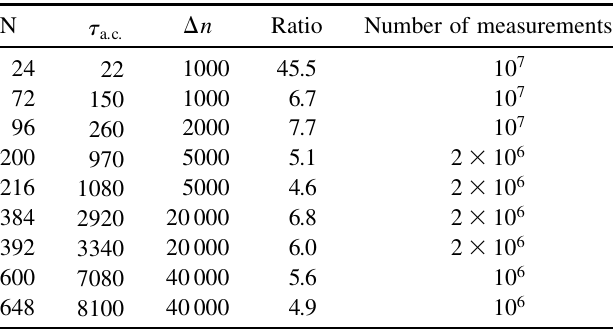
TABLE I. (cid:5) a : c : autocorrelation times for the two site- correlation functions compared to the number of elementary steps between two measurements ð (cid:1) n Þ